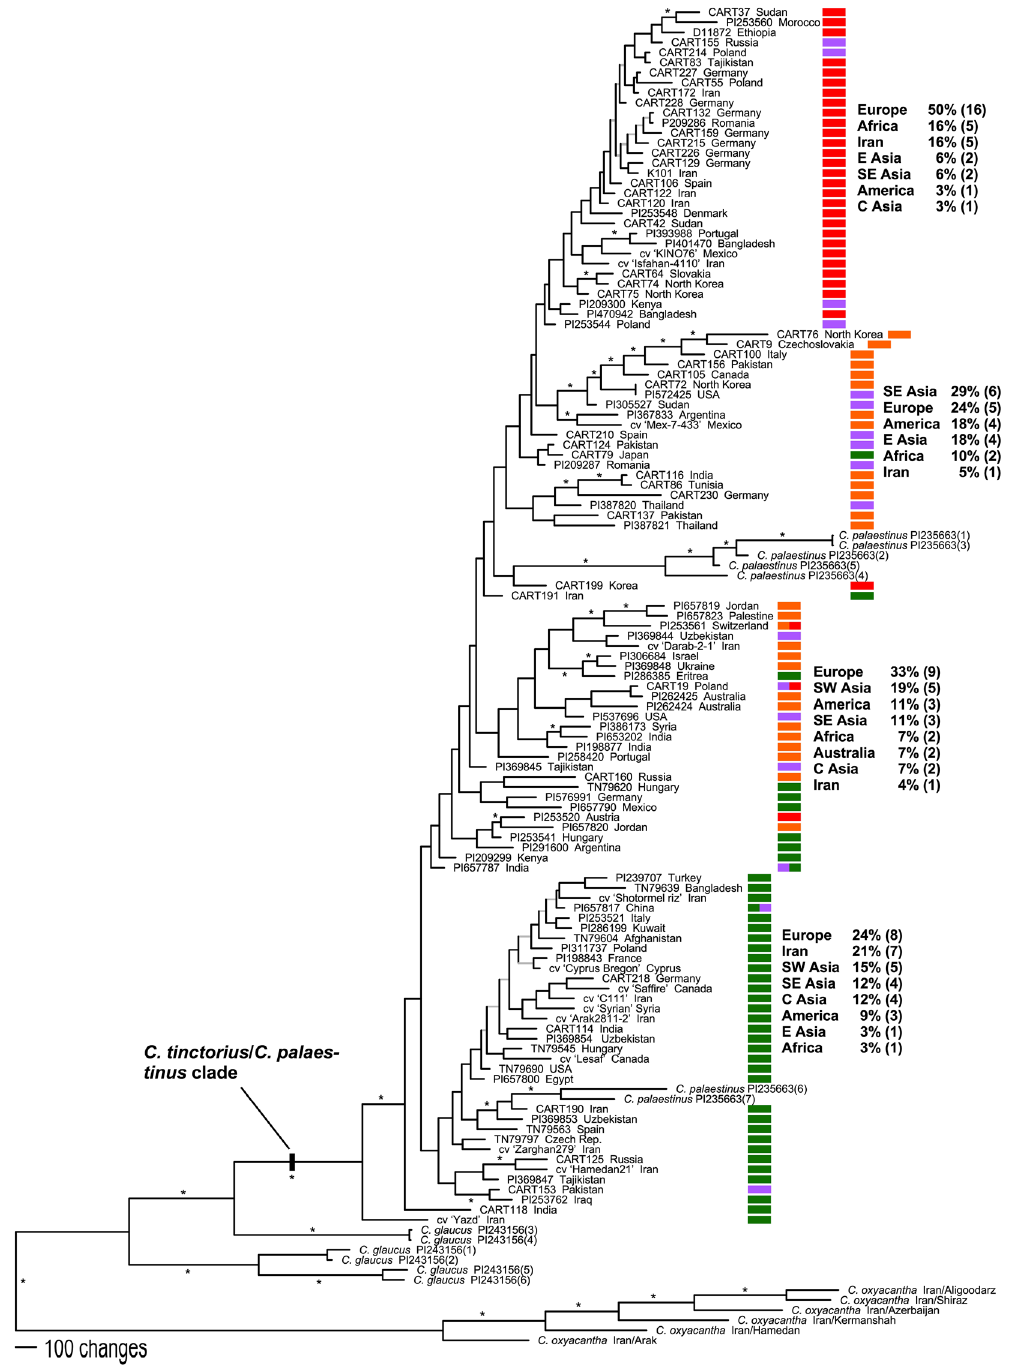
Figure 3. One out of four equally parsimonious trees of a GBS-derived MP analysis of a large and geographically diverse set of 114 safflower accessions. The tree was rooted with C. oxyacantha. Bootstrap values ≥ 75% are indicated by asterisks at the branches. Gray branches depict clades that were not recovered in all MP trees and collapse in the strict consensus tree. Colored bars provide the assignment of safflower individuals to four intraspecific groups according to a population structure analysis. To the right of the groups the proportion of members derived from certain geographical areas are